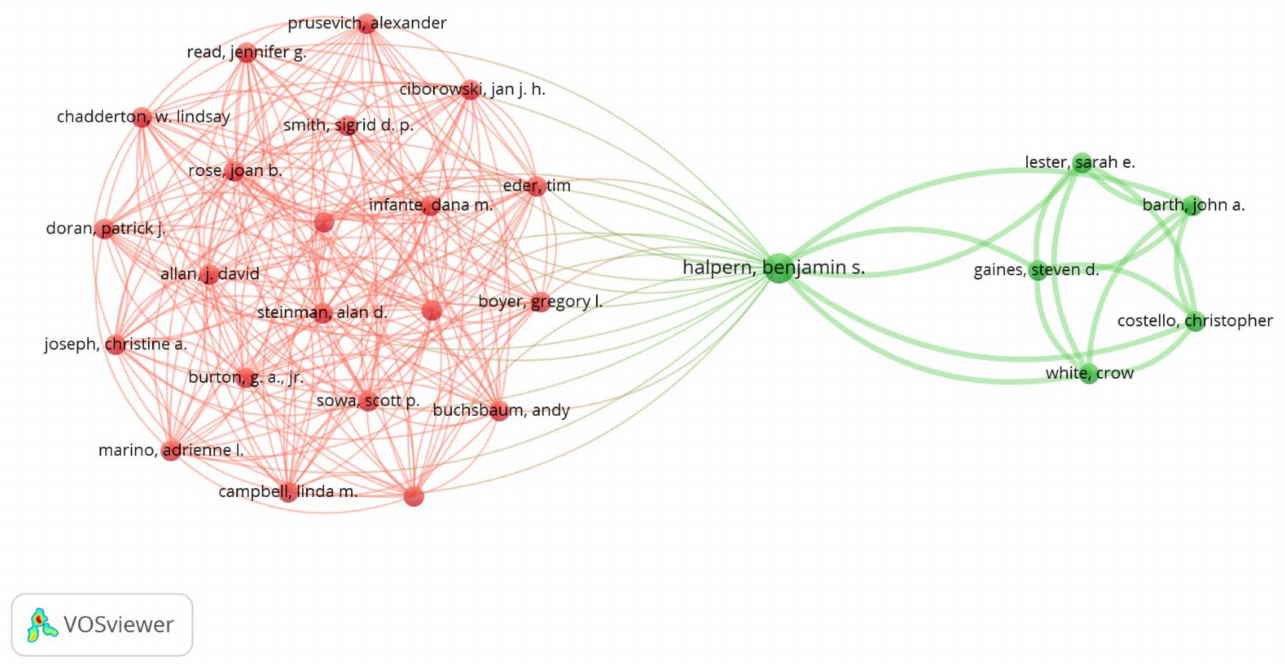
Figure 6. Co-authorship network of the most productive authors related to ecosystem services research in Web of Science Core Collection (WoSCC) database obtained by the highly cited journals from 2000 to 2020. Note: The threshold value = 3, applied for highly cited articles of 128, resulting in 27 authors. The bubble size shows the total number of highly cited articles, the line thickness shows the linkage’s strength, and the color shows the